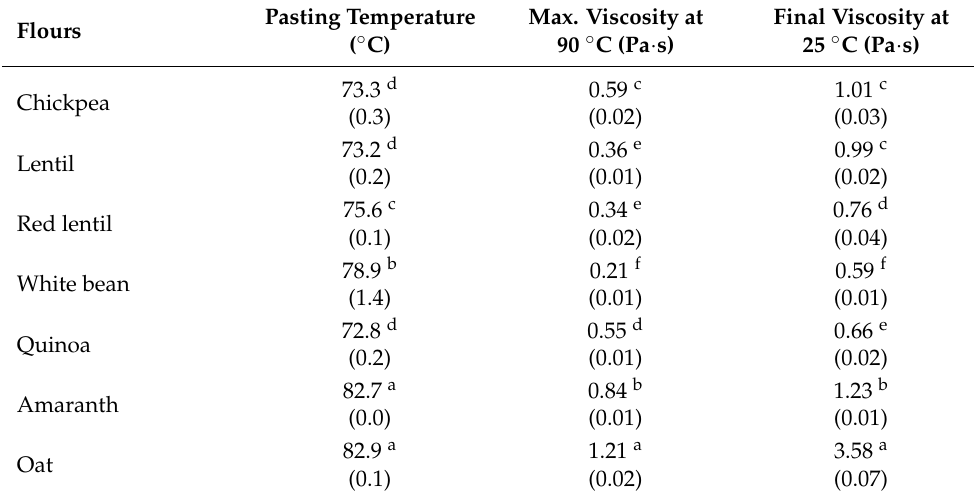
Table 4. Mean values of the pasting temperature, maximum viscosity at 90 ◦ C, and final viscosity at 25 ◦ C of flours from the testing of thermo-mechanical processes. Standard deviation in brackets.